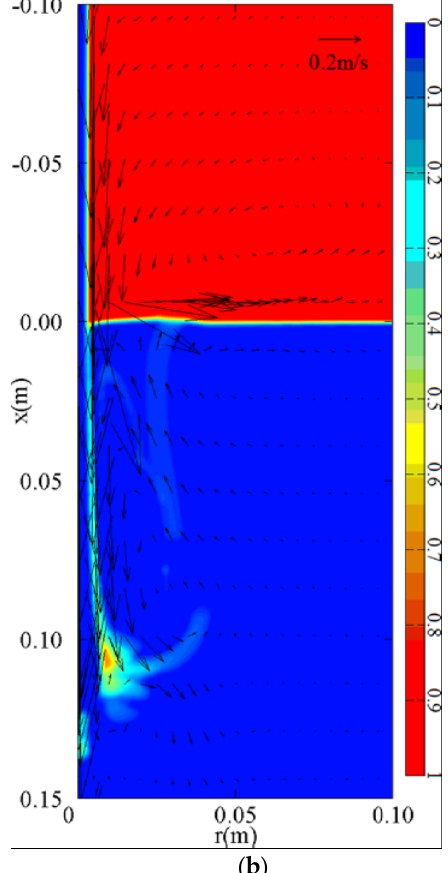
Figure 7. The mixture velocity vectors and AVF contours for V 0 = 2 m/s and L 1 = 0.141 m of ( a ) snapshot and ( b ) time-averaged values.